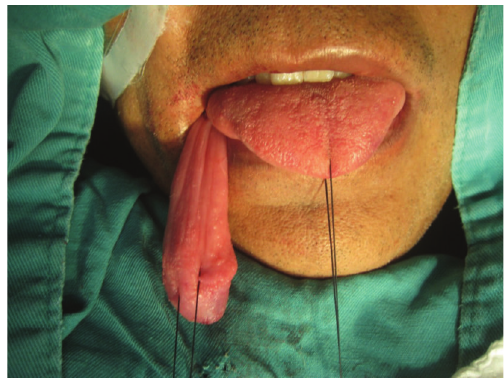
Figure 4: Lesion stained with